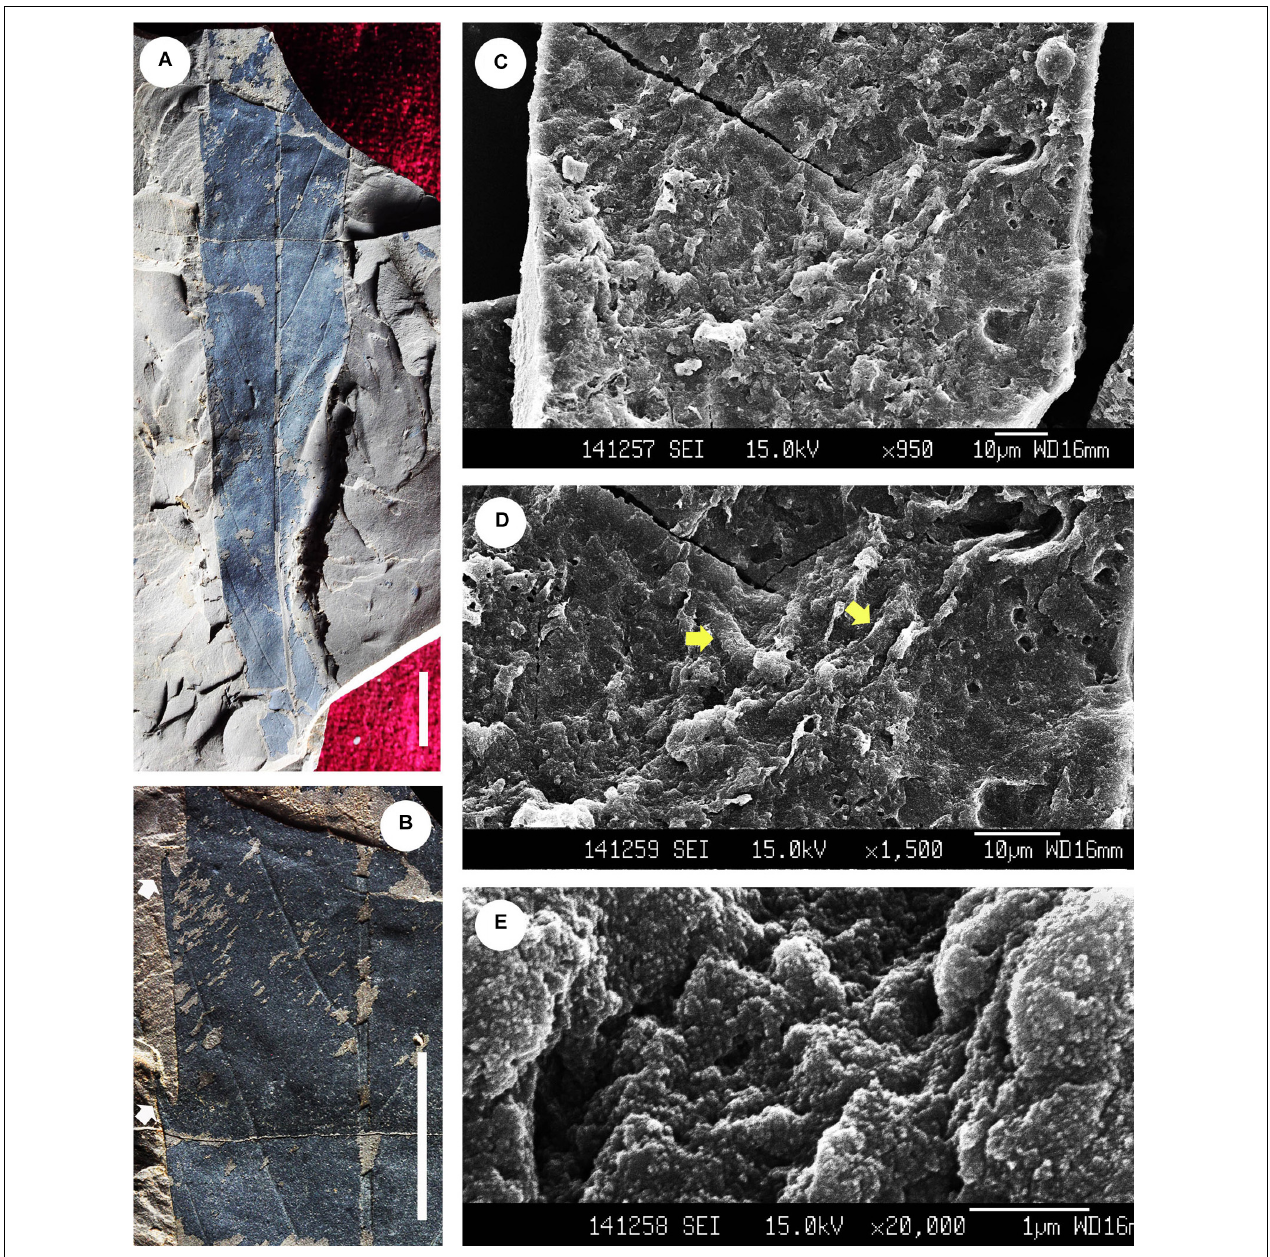
FIGURE 5 | Morphology of Castaneophyllum hainanensis sp. nov. (A) Holotype. Specimen No. CC-1260, showing leaf morphology; (B) enlargement of (A) , showing the venation, arrows indicate teeth; (C) SEM image showing the structures on the outer surface of leaf; (D) yellow arrows indicate the solitary trichomes on the outer surface of leaf; (E) SEM image showing rugose structures on the outer surface of leaf. Scale bars: 10 mm (A,B)